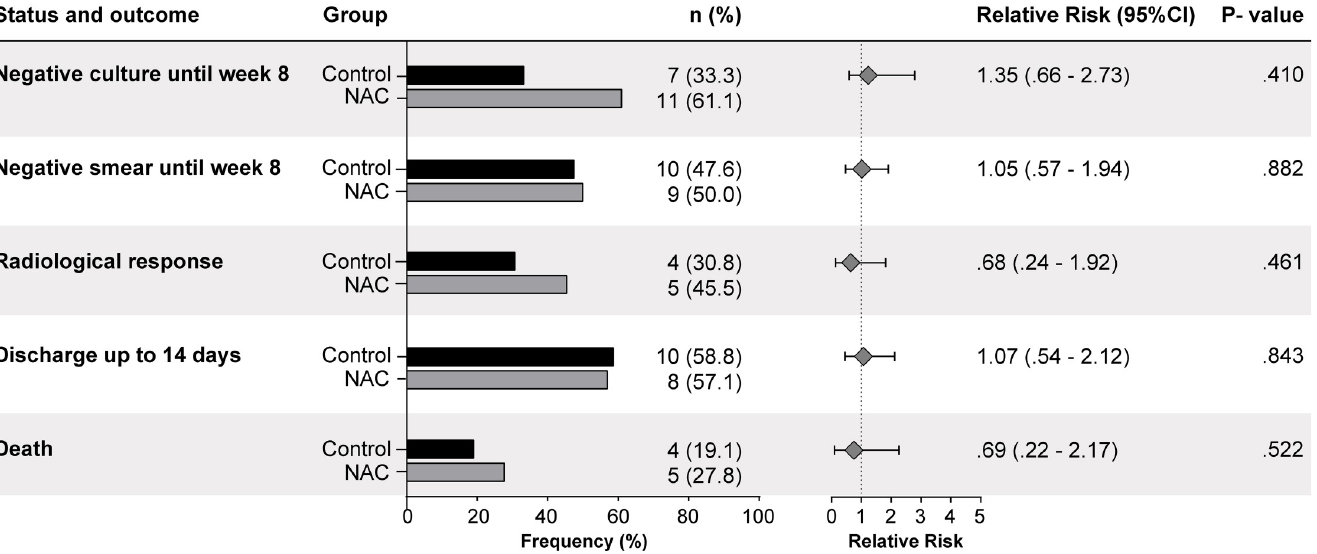
Fig 2. Major outcomes and respective 95% confidence intervals. P-values refer to RR